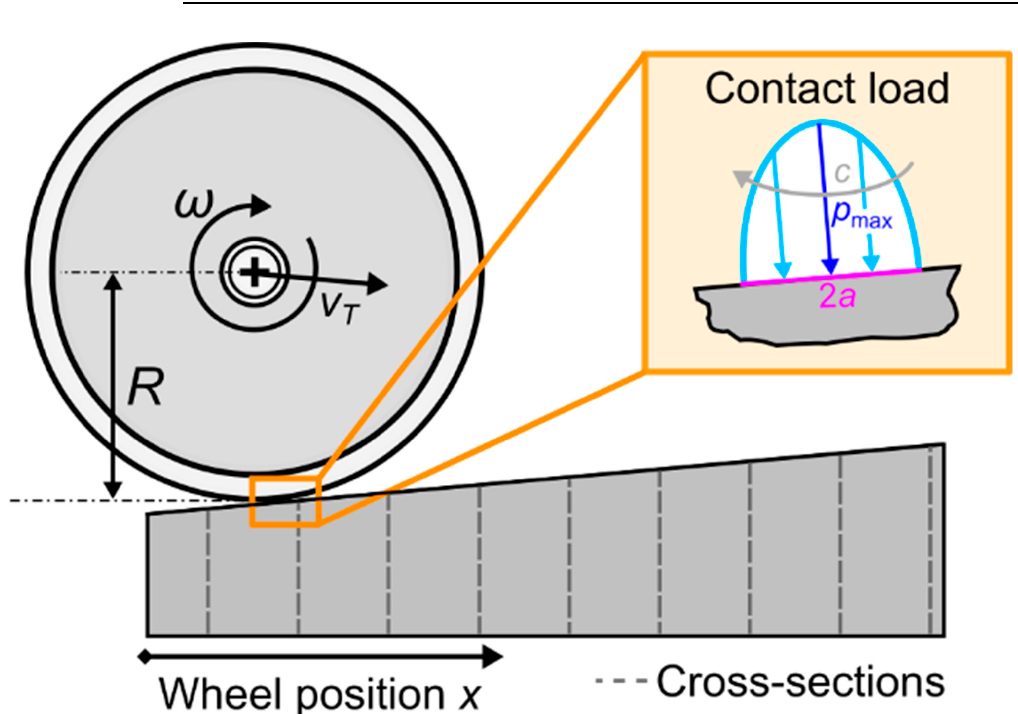
Figure 11. Definition of cross sections for local contact parameter extraction shown in a longitudinal 2D cut of the impact model.